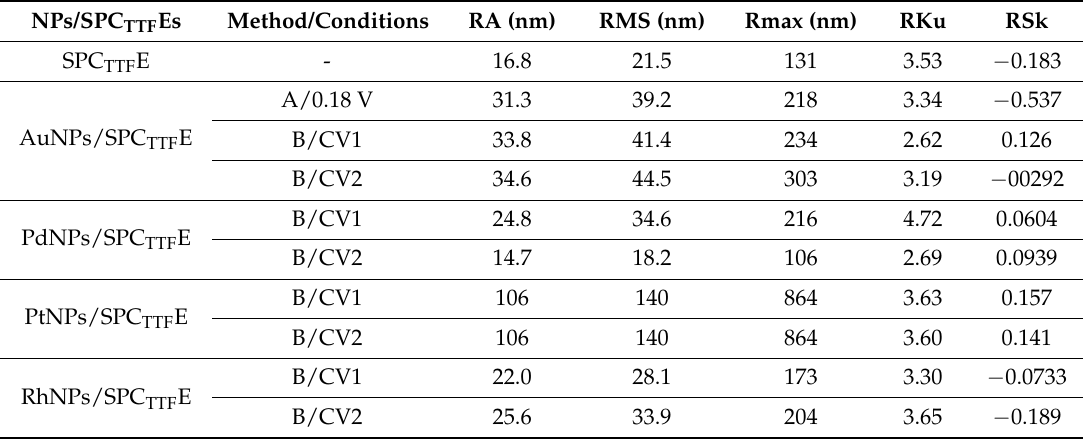
Table 3. AFM parameters of modified SPC TTF Es with metallic NPs.